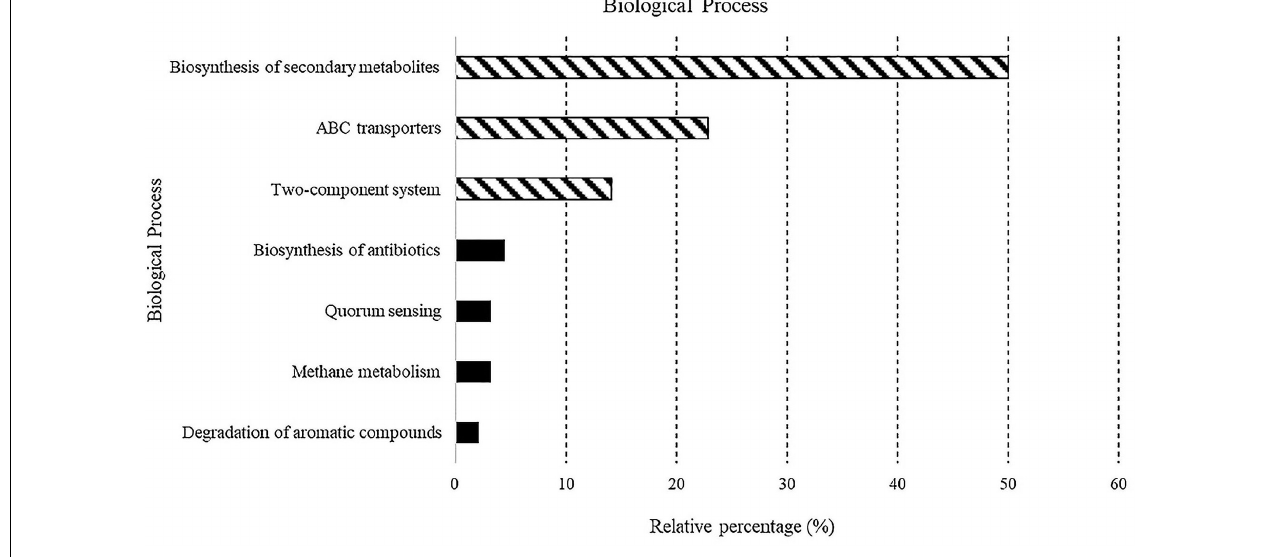
FIGURE 4 | Predicted biological processes expressed as percentages in all